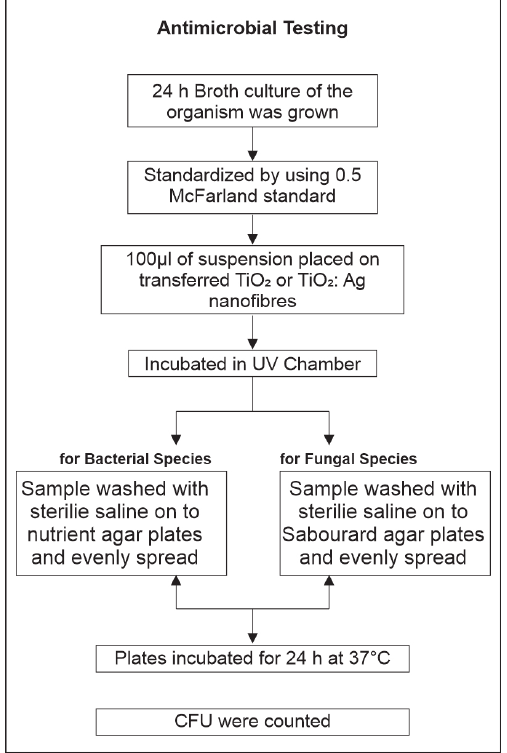
Fig. 1. Flowchart of antimicrobial